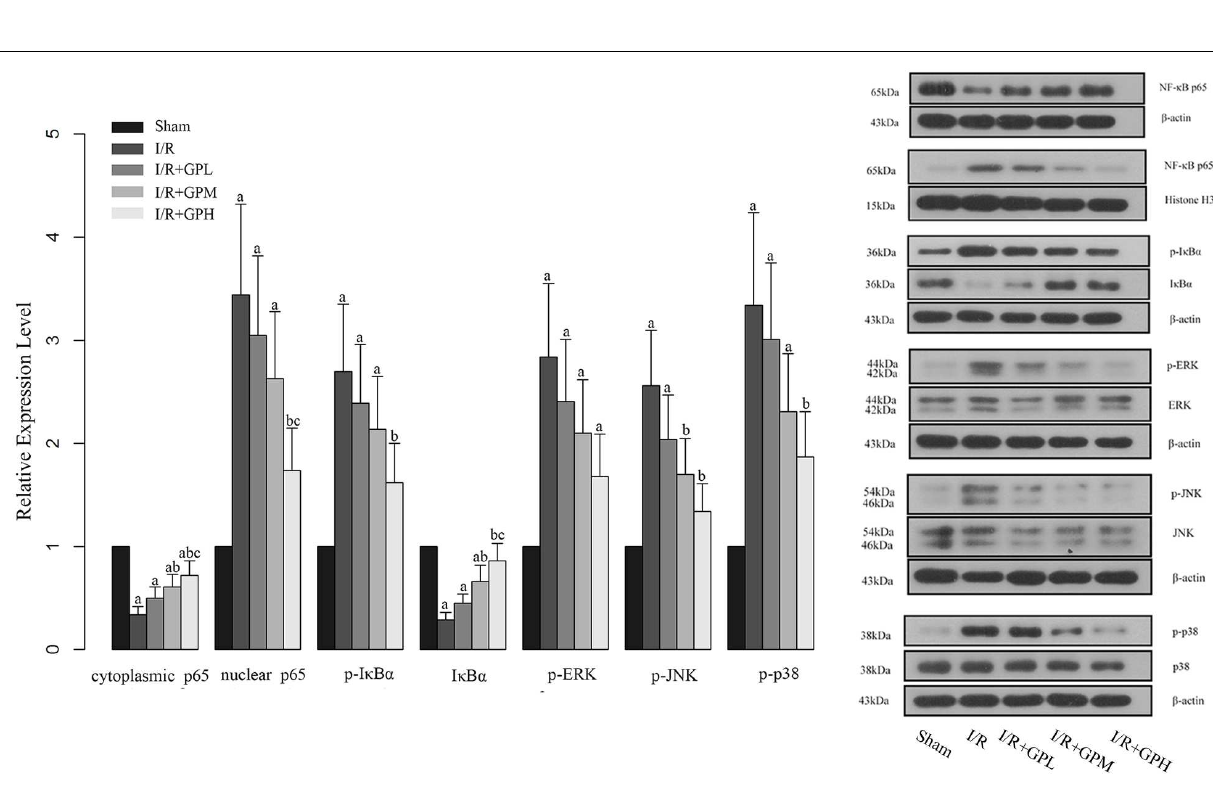
Frontiers in Pharmacology |